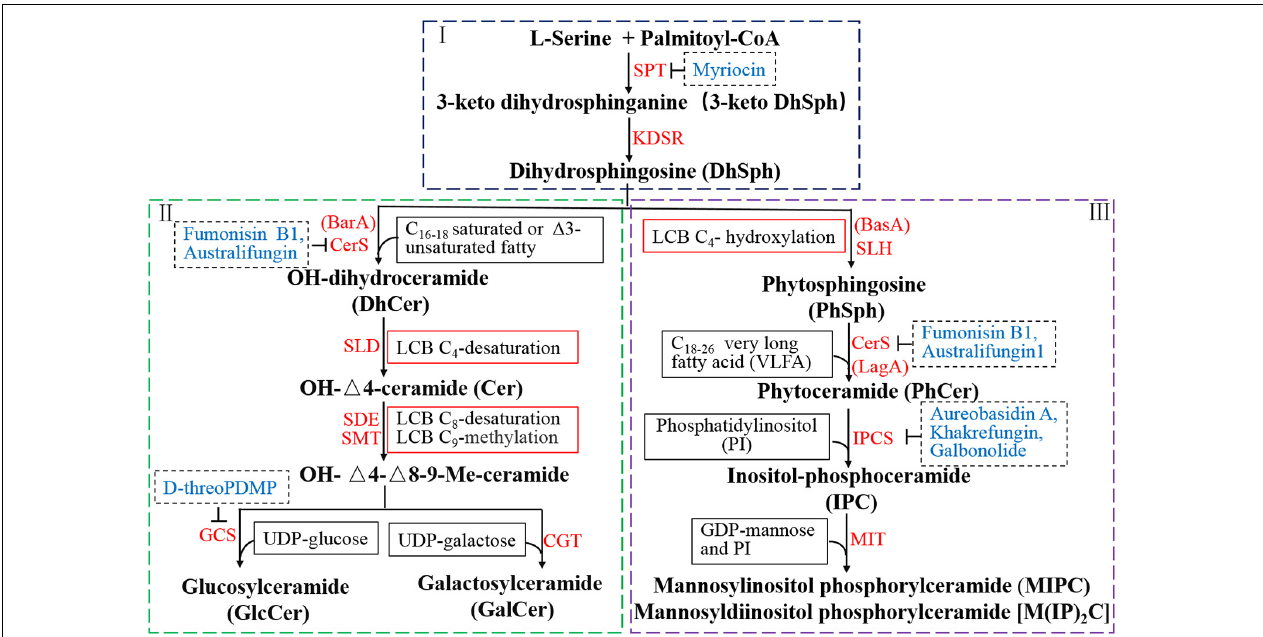
FIGURE 2 | Reorganized biosynthetic pathway of glycosphingolipid in filamentous fungi. The first part (I) involves two key enzyme-catalyzed reactions and is the starting point and common to neutral and acidic GSL synthesis. The second part (II) represents the biosynthetic pathway of neutral GSLs (GlcCer and GalCer) from DhSph including four enzyme-catalyzed reactions. GlcCer and GalCer are the final products of neutral GSL pathway in filamentous fungi. The third part (III) is the biosynthetic process of acidic GSLs, including the production of IPC, MIPC, and M(IP) 2 C, which also starts from DhSph and includes three enzyme-catalyzed reactions. IPCs, used as building blocks for more complex molecules, are further modified upon addition of mannose and a second inositol phosphate group to generate MIPC and M(IP) 2 C. Red texts represent genes or relative enzymes involved in the GSL pathway. Blue texts indicate the inhibitors of the specific enzyme in the biosynthetic